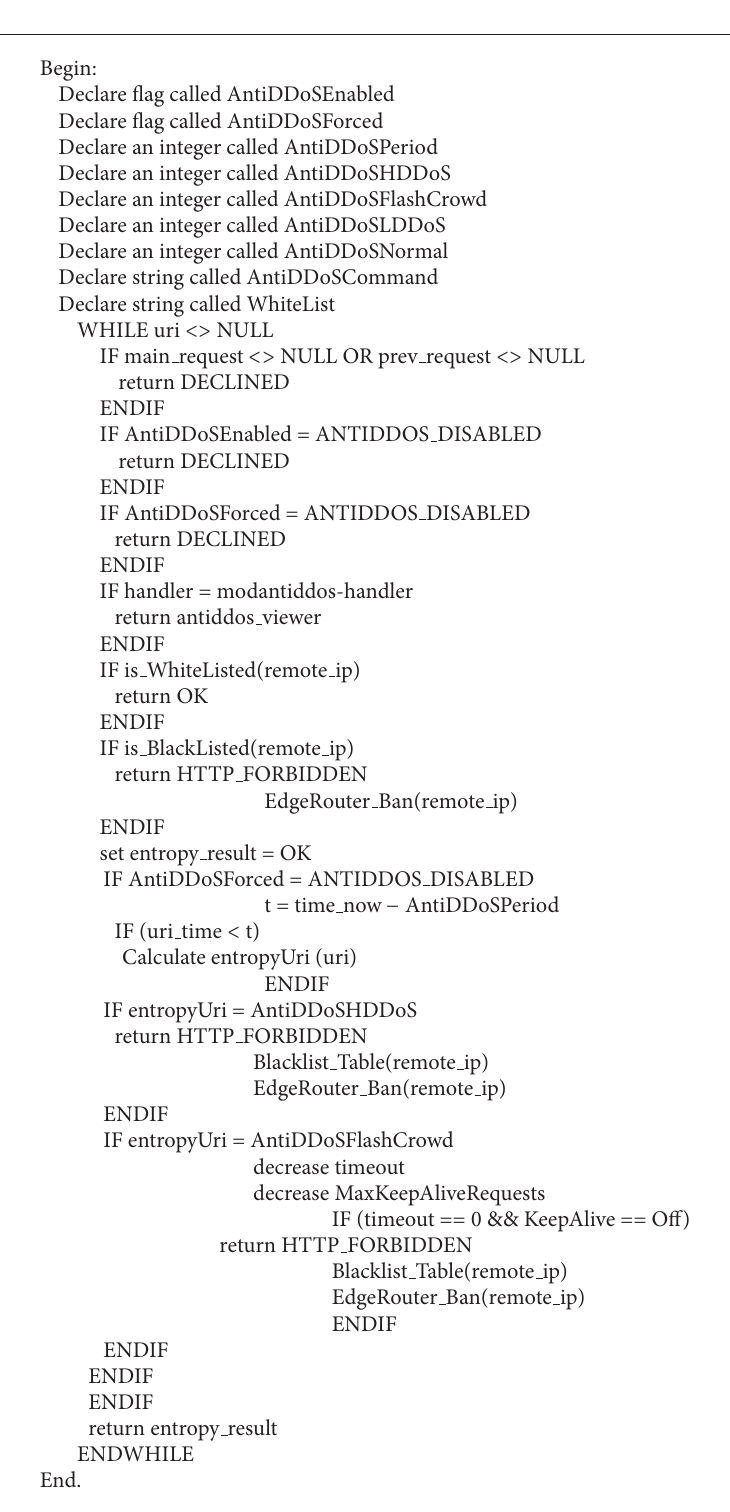
Algorithm 4: Flexible advanced entropy based (FAEB)